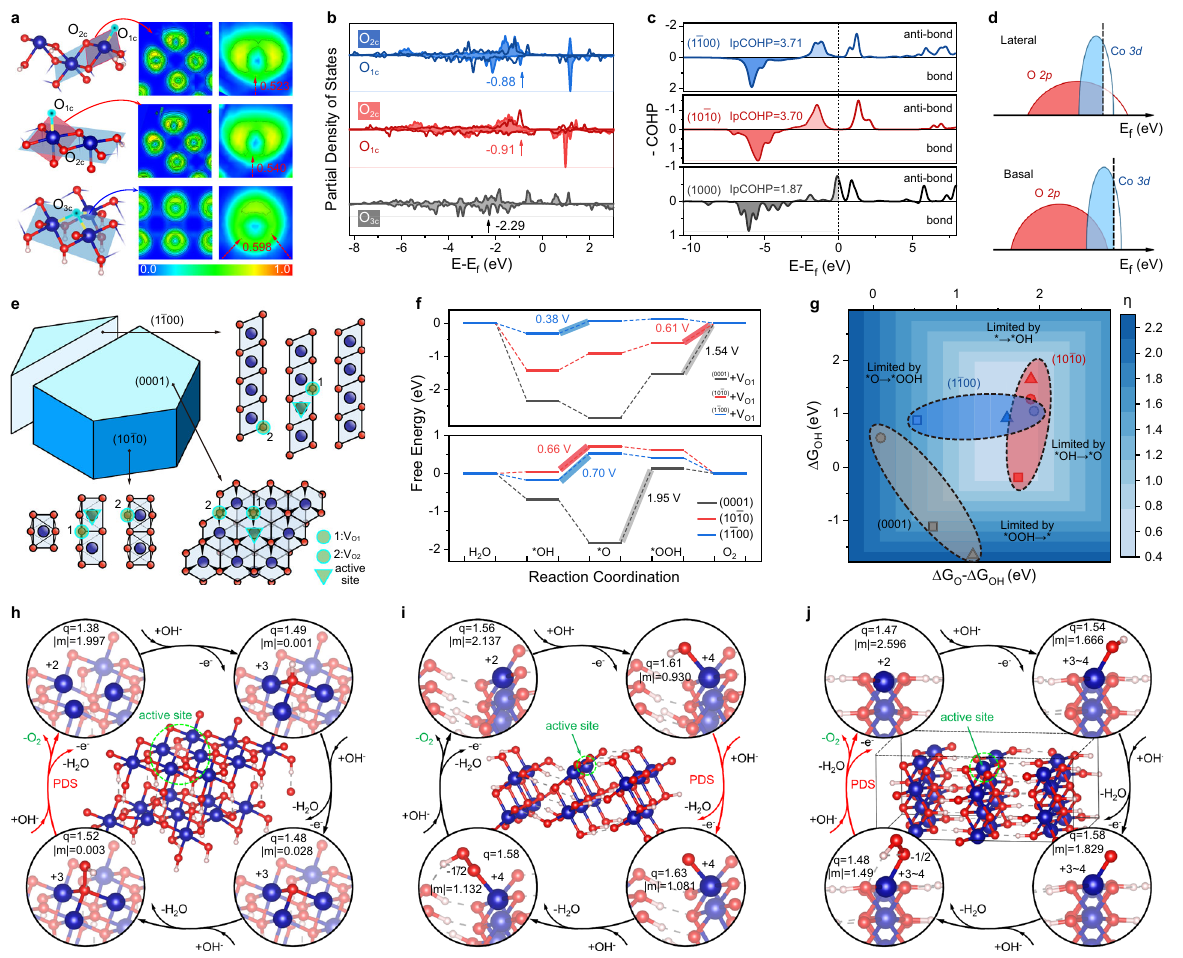
Fig. 5 | Theoretical calculation of the active sites of crystalline CoOOH. a Schematics depicting the arrangement of surface atoms on (0001), (10 (cid:1) 10), and (1 (cid:1) 100) facets and their corresponding electron localization function (ELF) contour slices of the surface Co-O bond; b The electron density of states for the oxygen 2 p orbitalsofO 2c /O 3c atoms(shaded)andO 1c atoms.(1 (cid:1) 100)isdisplayedinblue.(10 (cid:1) 10) is displayed in red and (0001) in black. c Crystal orbital Hamilton populations (COHP) of the surface Co-O bond (Co CUS -O 1c for lateral facets and Co CUS -O 3c for basal facets). (1 (cid:1) 100) is displayed in blue. (10 (cid:1) 10) is displayed in red and (0001) in